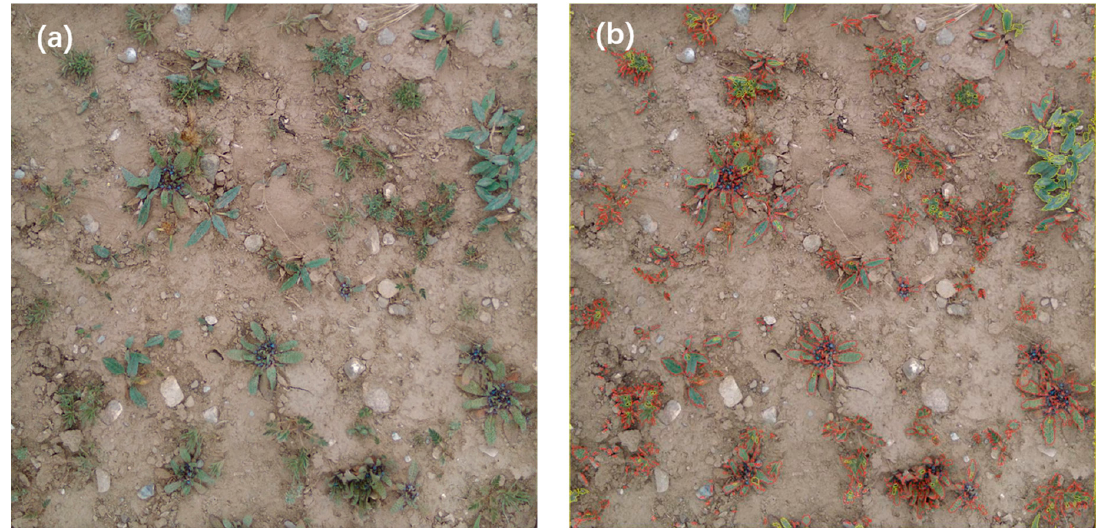
Figure 4. E ff ect diagram ( a ) original image; ( b ) processing result of image (Red curves and yellow curves indicate vegetation contour, non-vegetation contour